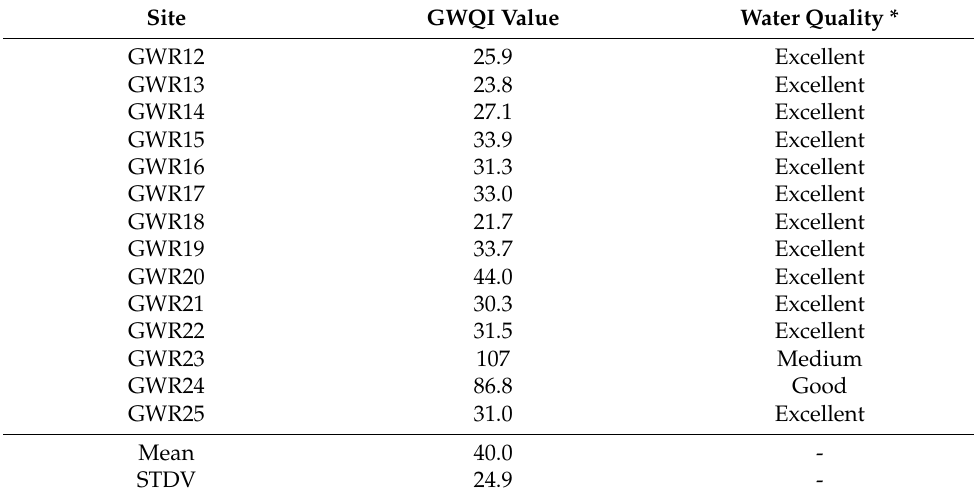
Table 5. Groundwater quality index (GWQI) of the studied karst